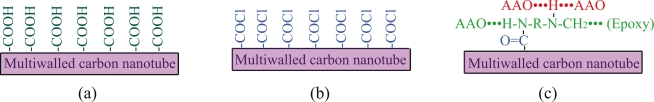
Illustration of preparation of active carbon nanotubes: (a) nitric acid refluxing, (b) converting –COOH groups into acid chloride functional groups, (c) bonding enhancement between carbon nanotubes and AAO; carbon nanotubes and amine groups in epoxy backbones.